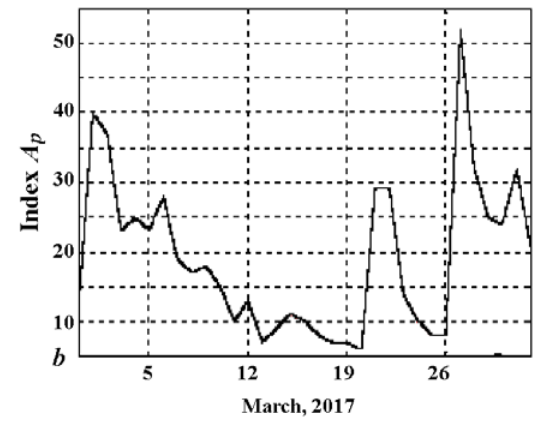
Fig. 4. A p -index.